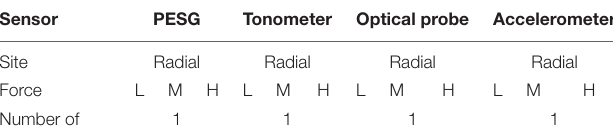
TABLE 2 | The sequence of pulse wave acquisition at the three levels of contact force (where, L, M, and H represent light, medium, and heavy force, respectively). Sensor PESG